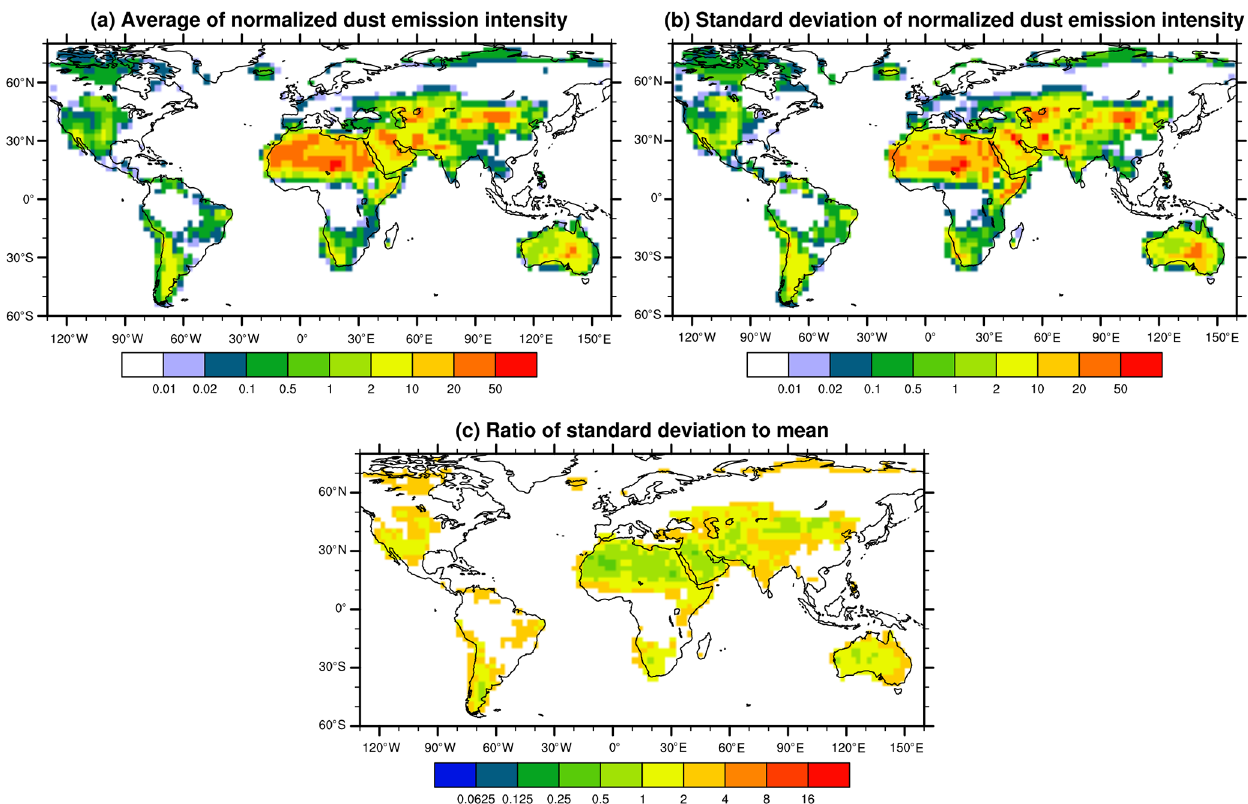
Figure 7. Mean, standard deviation, and relative standard deviation (also known as coefficient of variation) of the normalized dust emission flux from 15 CMIP5 models. The relative standard deviation is derived by calculating the ratio of the standard deviation to the